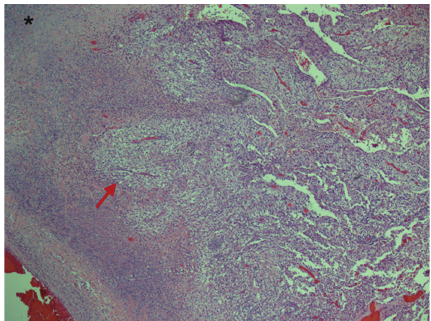
Figure 1: Low power microphotograph (10x) shows pulmonary parenchymal involvement by metastatic clear cell renal cell car- cinoma (red arrow), adjacent to an area of extensive necrosis (asterisk).